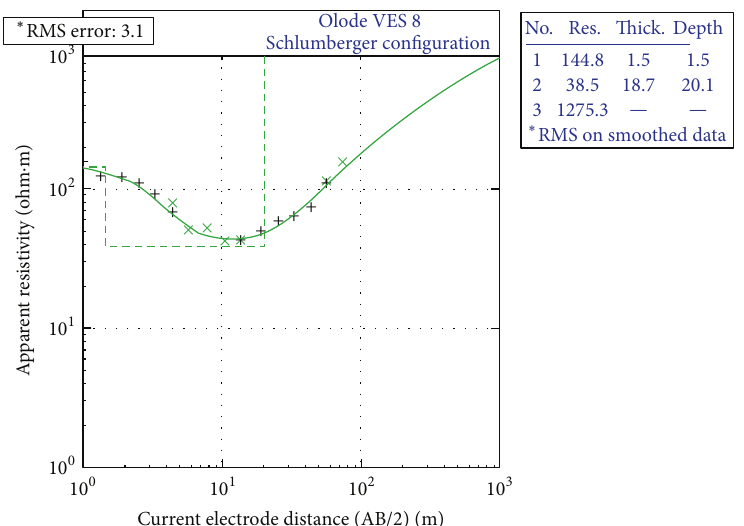
Figure 20: Sounding curve of VES